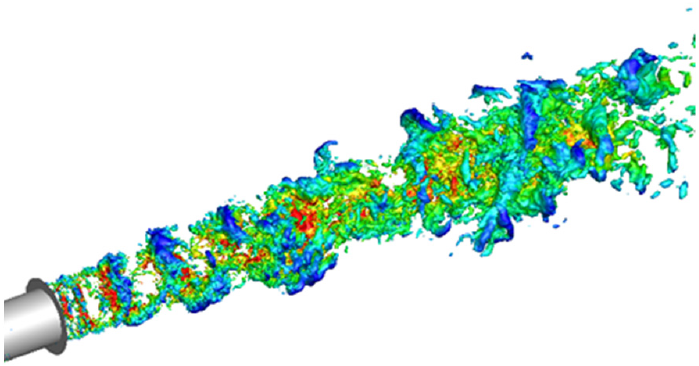
Figure 4. Streamwise variation of the shear layer momentum thickness.